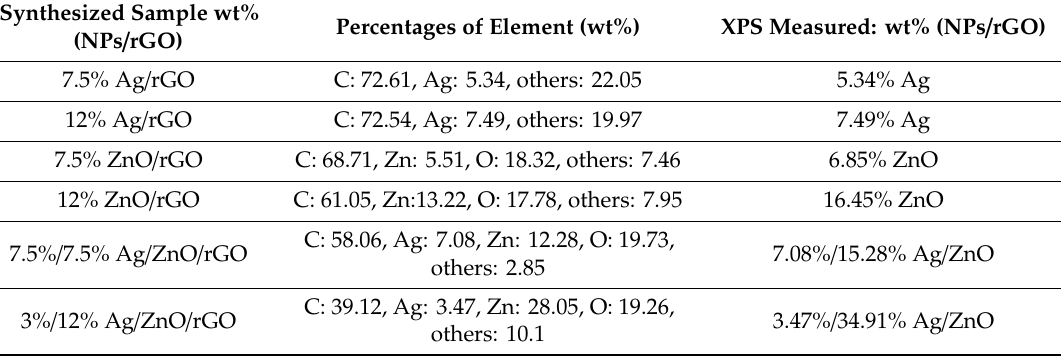
Table 1. Quantitative XPS measurement of 5.34% Ag / rGO, 7.49% Ag / rGO, 6.85%ZnO / rGO, 16.45% ZnO / rGO, 3.47 / 34.91% Ag / ZnO / rGO, and 7.08 / 15.28% Ag / ZnO / rGO.